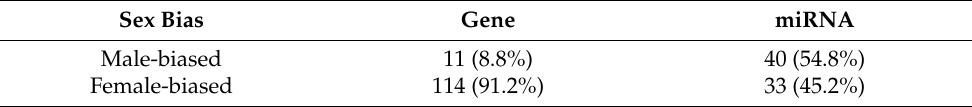
Table 2. Summary of sex-biased genes in BC and miRNA in five TCGA cancers (head and neck